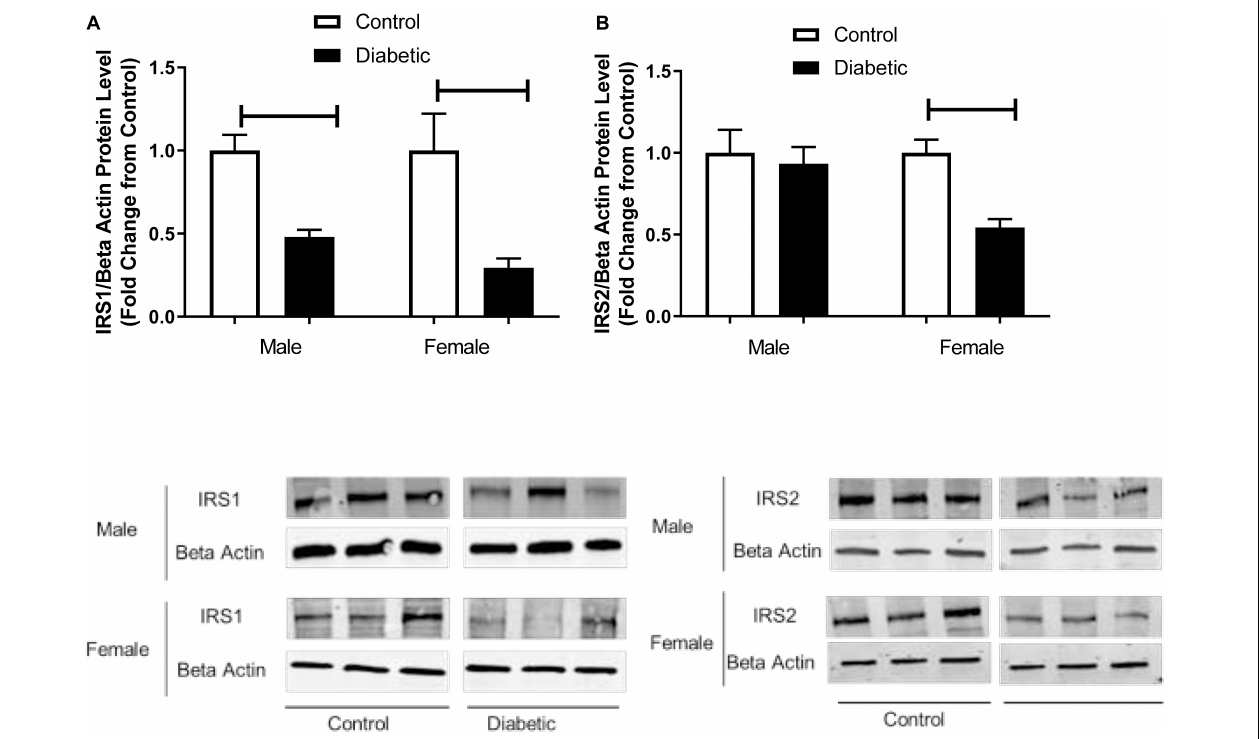
FIGURE 1 | Western blot analysis of IRS1 and IRS2 expression in control and UCD-T2DM rat aorta. Protein levels of (A) aortic insulin receptor substrate-I (IRS1) and (B) insulin receptor substrate-2 (IRS2) from the samples of male and female control and diabetic rats. IRS1 (A) and IRS2 (B) were quantified by densitometry and normalized to corresponding beta actin. Values are represented as mean ± SEM. Each bar represents the values obtained from n = 4–5 animal s per group. To show representative bands, images from different parts of the same gel have been juxtaposed, indicated by white dividing lines. Capped lines indicate significant differences between two groups ( p < 0.05), as analyzed by unpaired Student ’s t